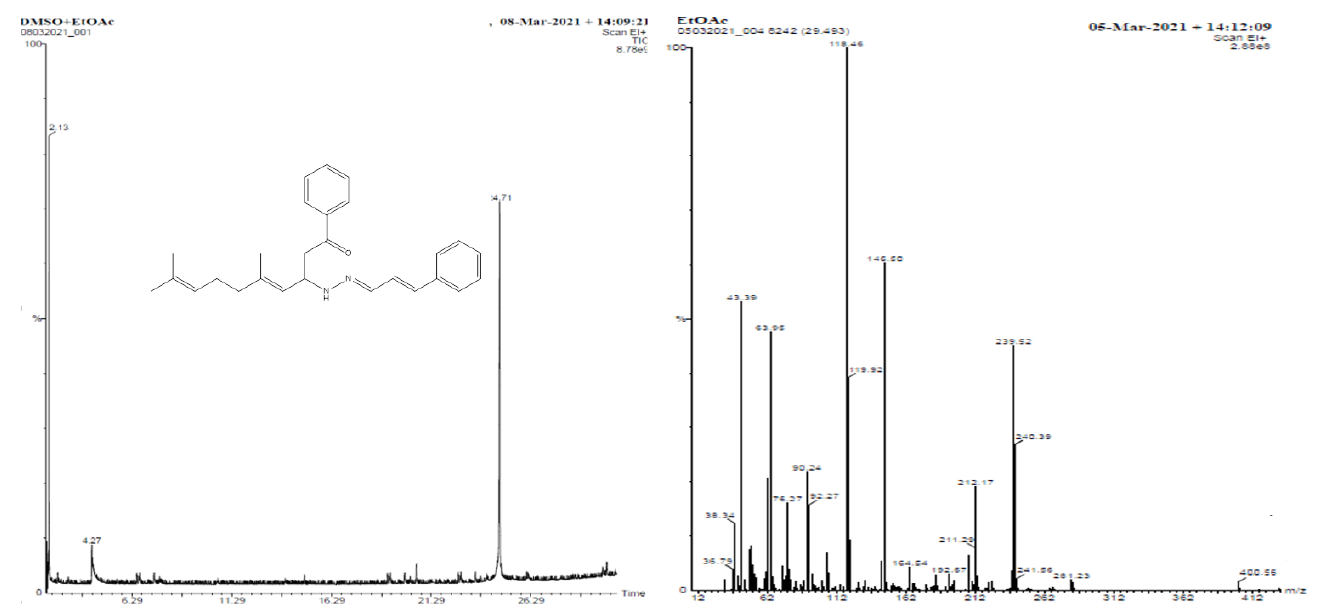
Figure 4. GC-MS analysis of compound 1f .